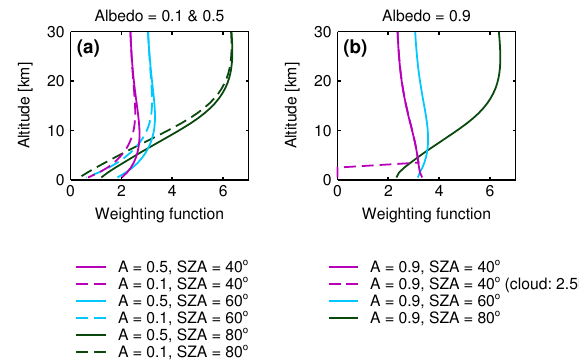
Fig. 3. BrO weighting functions at 344.6nm for various solar zenith angles (SZA) and surface albedos (A), for (a) clear sky conditions and (b) clear and cloudy sky conditions, where the cloudy case is for an optically thick cloud (cloud extinction coefficient = 300) at 2.5 km altitude.